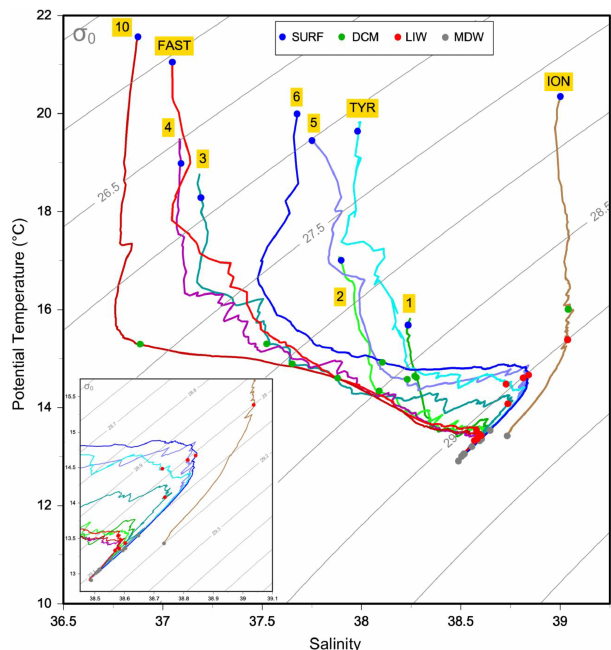
Figure 2. T/S diagram for the sampled stations. Main water masses are as follows. MAW: modified Atlantic water; LIW: Levantine intermediate water; WMDW: western Mediterranean deep water; EMDW: eastern Mediterranean deep